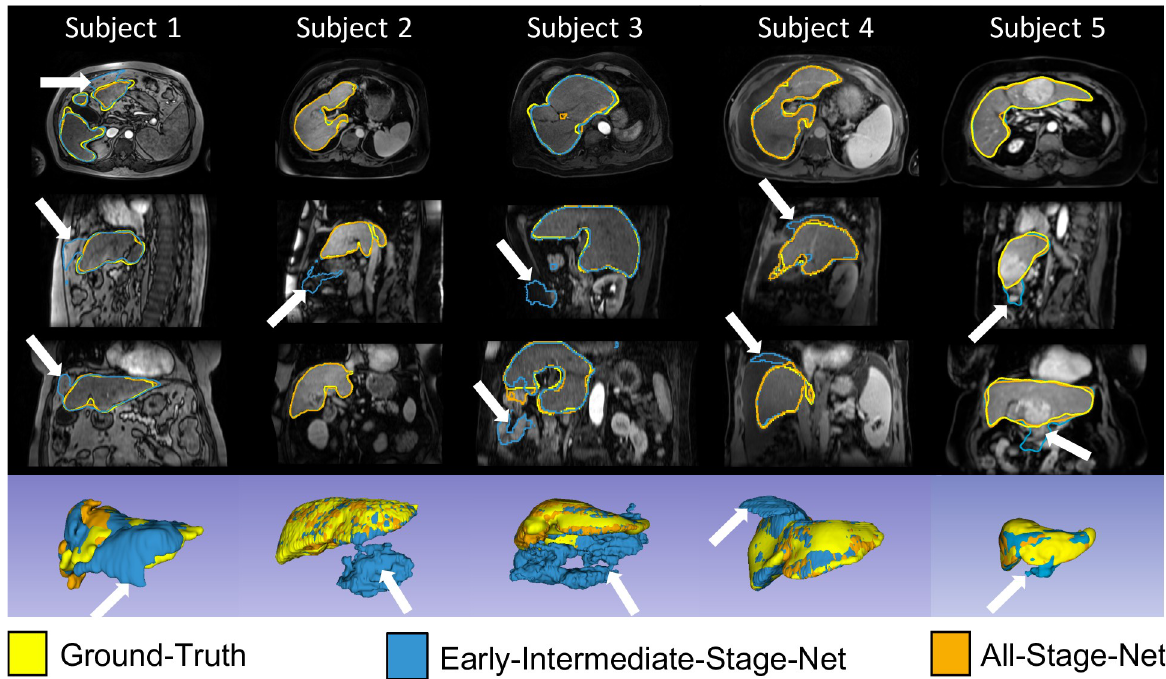
Fig 4. Examples of the superior liver segmentation performance of the All-Stage-Net over the Early-Intermediate-Stage-Net. Columns show results from five different subjects. Rows from top to bottom show axial, sagittal and coronal arterial-phase magnetic resonance images on which the All-Stage-Net (overlaid in orange) outperformed the Early-Intermediate-Stage-Net (overlaid in blue). Expert ground-truth liver segmentations are overlaid in yellow. The last row displays the liver segmentations as 3D renderings. White arrows point on areas of liver segmentation failure of the Early-Intermediate-Stage-Net. While the Early-Intermediate-Stage-Net was trained only on patients with Barcelona Clinic Liver Cancer (BCLC) stages 0, A and B, the All-Stage-Net was trained on a training set spanning all BCLC cancer stages.